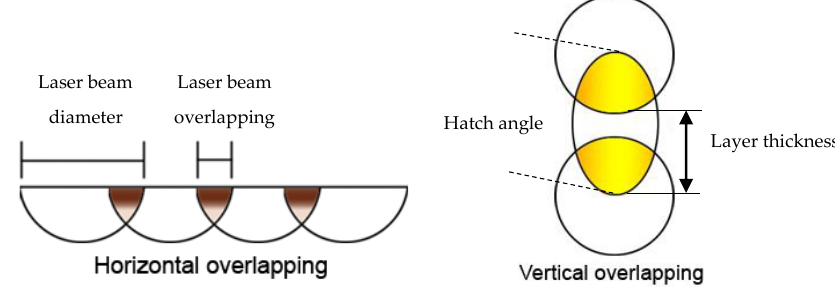
Figure 8. Illustration of vertical and horizontal laser overlapping.